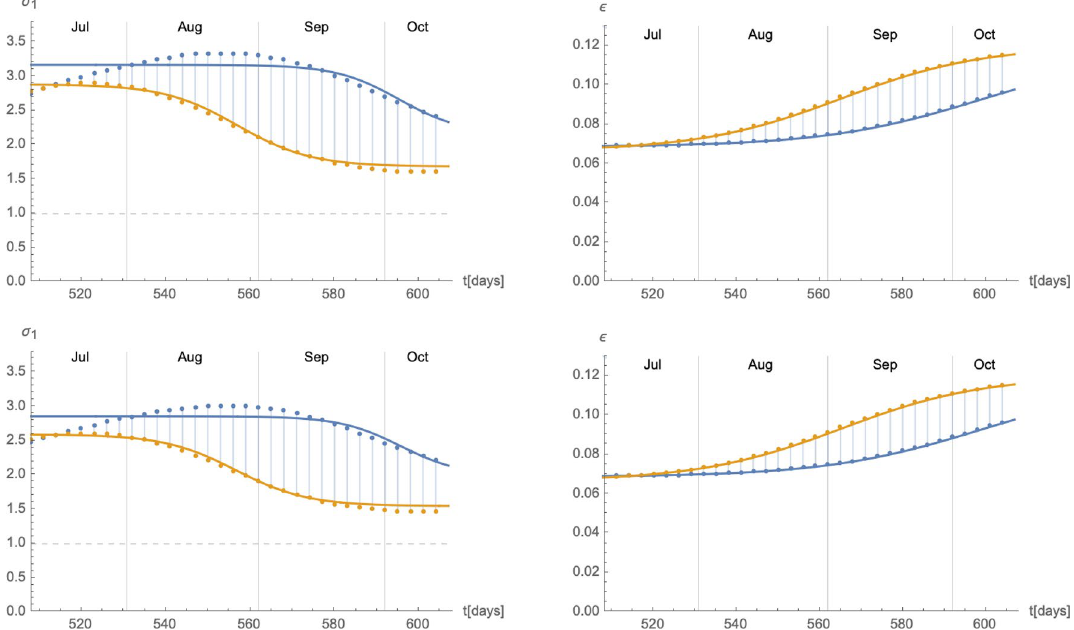
Figure 10. Time dependent parameters σ 1 (left panel) and ε (right panel) for the extremal cases of wave 4. The blue and orange colours are correlated with the curves in the right panel of Figure F10. The panels of the top row use p = 0.8 , while the panels in the bottom row use p = 0.9 in order to fit the data.